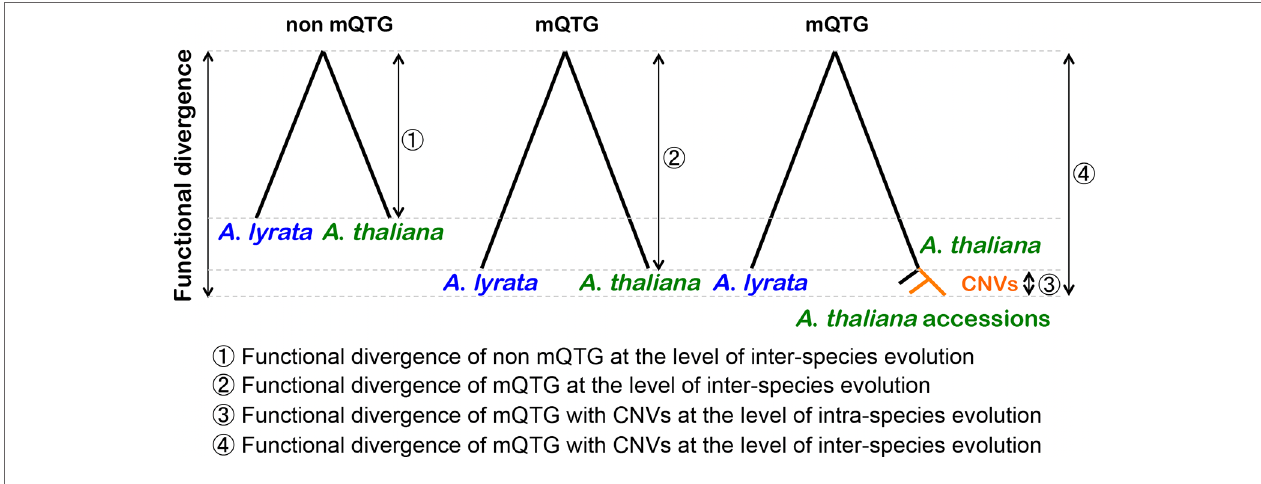
FIGURe 2 | Contribution of CNVs to the functional divergence of mQTGs at the inter-species and intra-species levels. The functional divergence of the metabolic quantitative trait genes (mQTGs) is higher than that of the other genes (non-mQTGs) between Arabidopsis lyrata and Arabidopsis thaliana (inter-species level). In A . thaliana , mQTGs tend to have copy number variants (CNVs) because of gene duplications. After a gene duplication event, the duplicated copies accumulate nonsynonymous mutations. This causes the functional divergence of the mQTGs among A . thaliana accessions (intra-species level). Consequently, CNVs induce the functional divergence of mQTGs between A . lyrata and A . thaliana